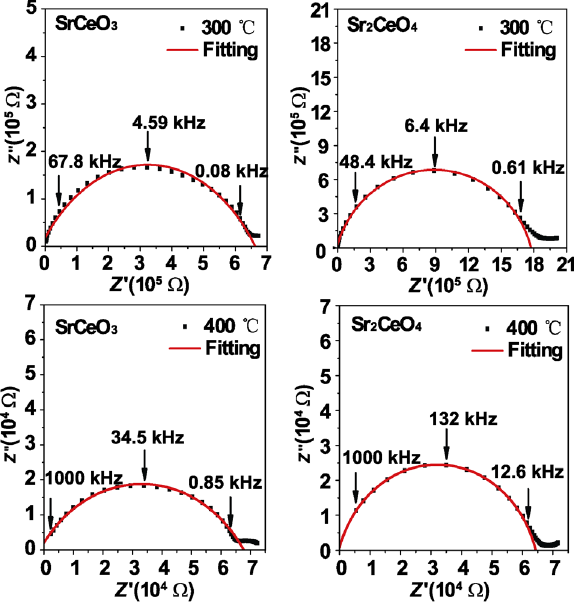
Fig. 6 Complex plane impedance plots (Nyquist plots) of the